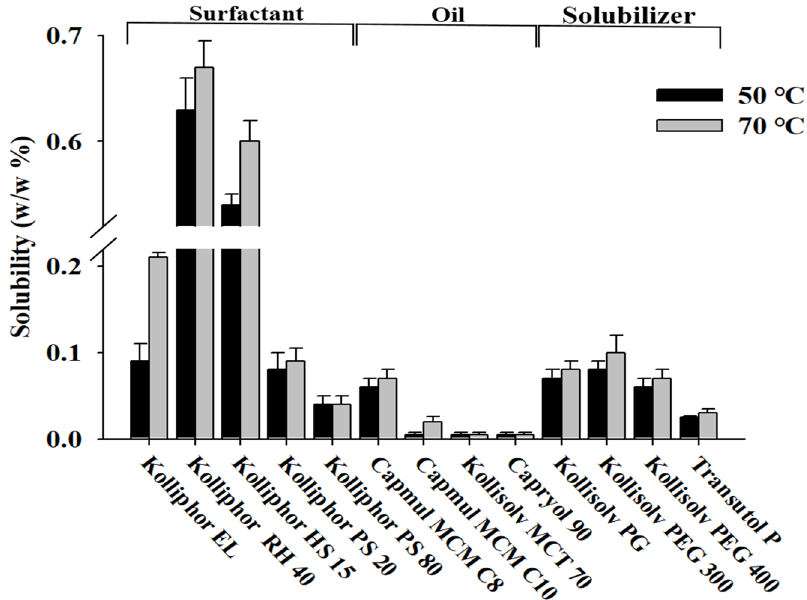
Figure 2. Solubility of ALH in various oils, surfactants, and solubilizers.